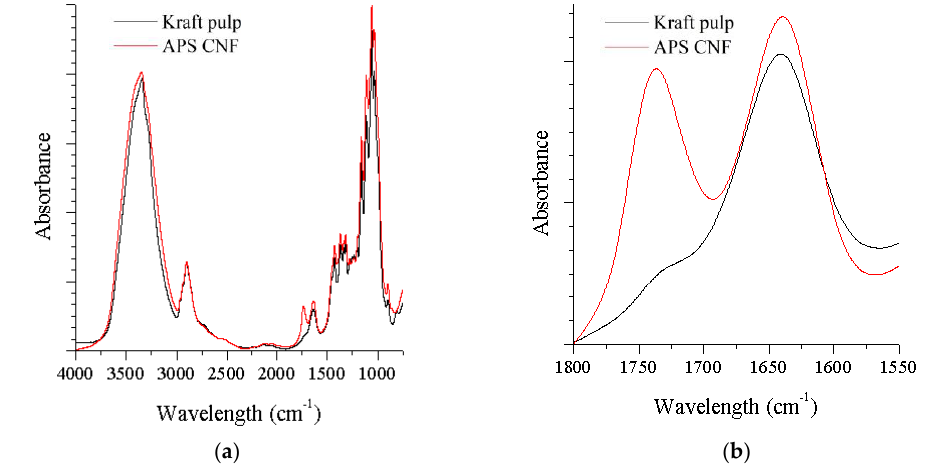
Figure 3. FTIR spectra of ammonium persulfate treated nanofibrillated cellulose compared to microcrystalline cellulose ( a ) spectra 4000–850 cm −1 ; ( b ) spectra 1800–1550 cm −1 .